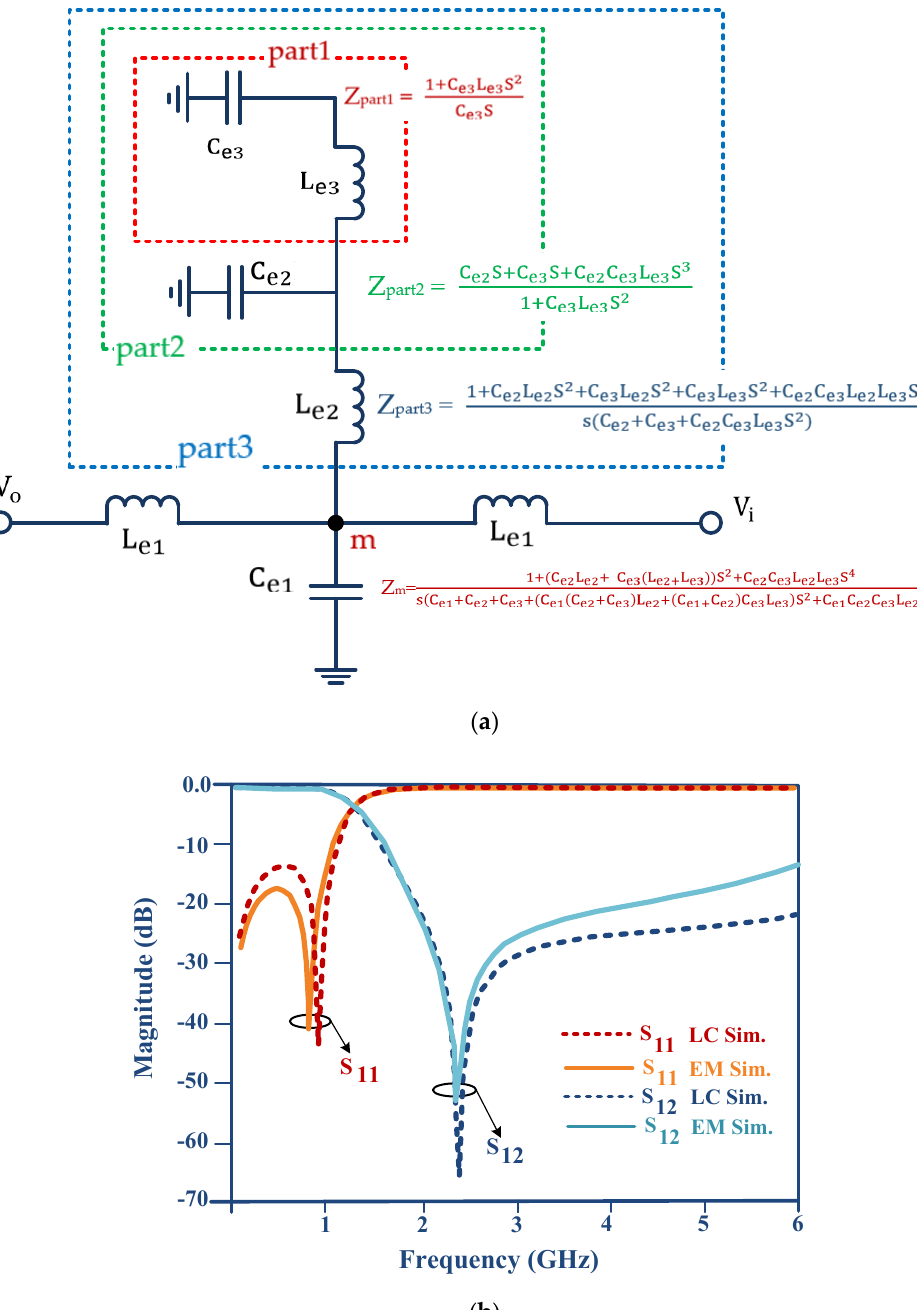
Figure 5. The ( a ) LC-equivalent circuit and ( b )the comparison of the LC-equivalent circuit response and EM structure of the half-circular resonator.